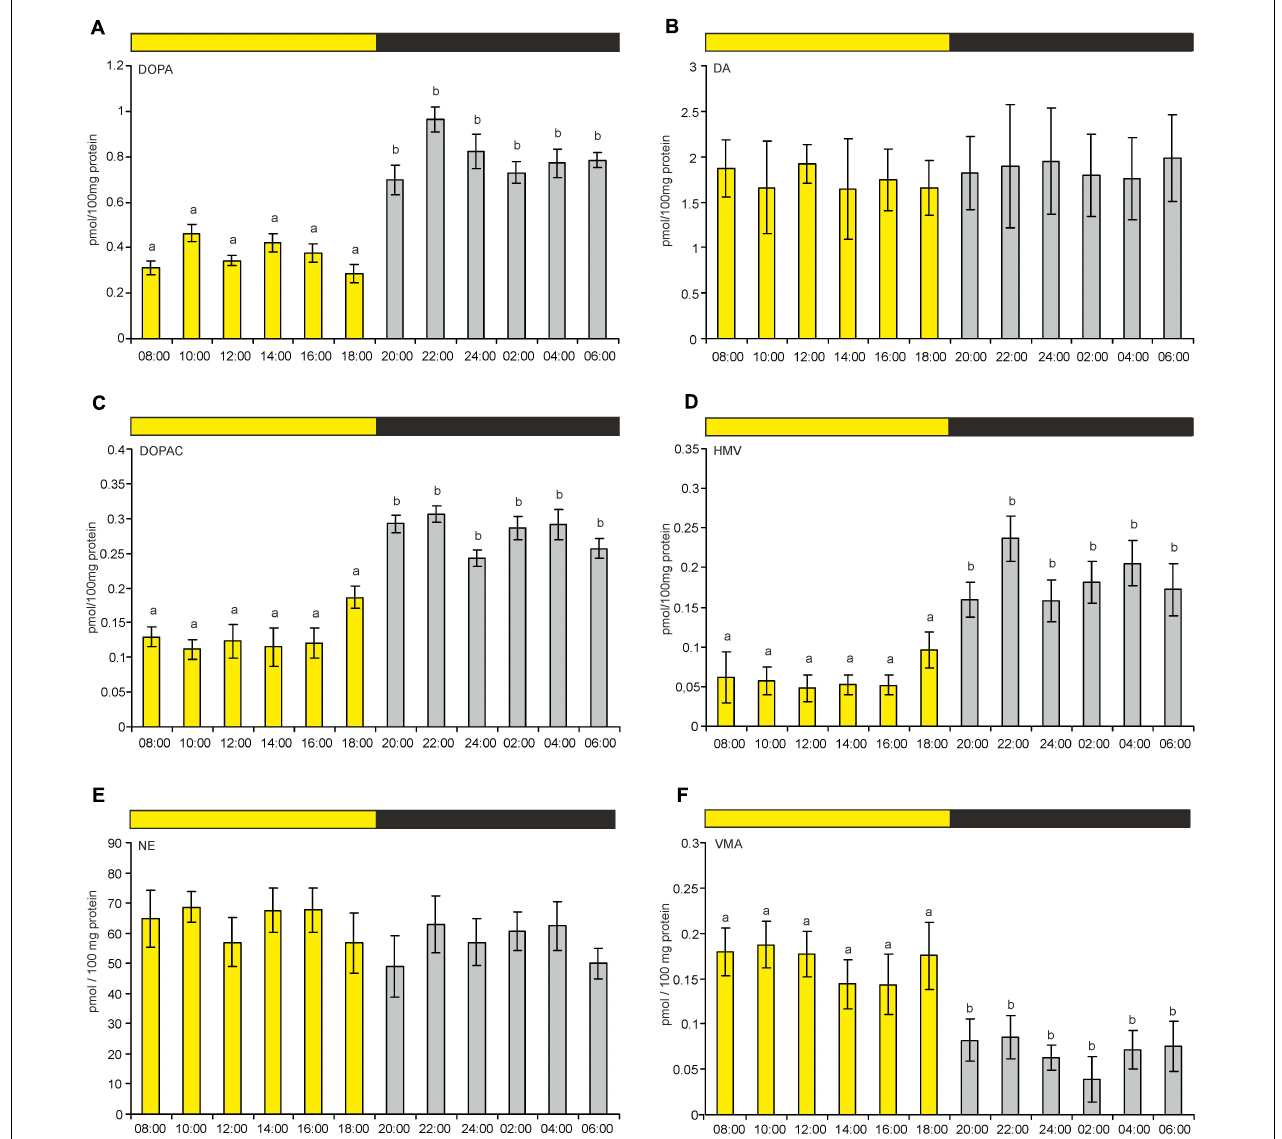
FIGURE 8 | (A–F) Content of DOPA, DA, DOPAC, HVA, NE, and VMA in goose pineal organs during a diurnal cycle (means and standard errors, n = 4). The values labeled with different letters above the bars differ significantly at p ≤